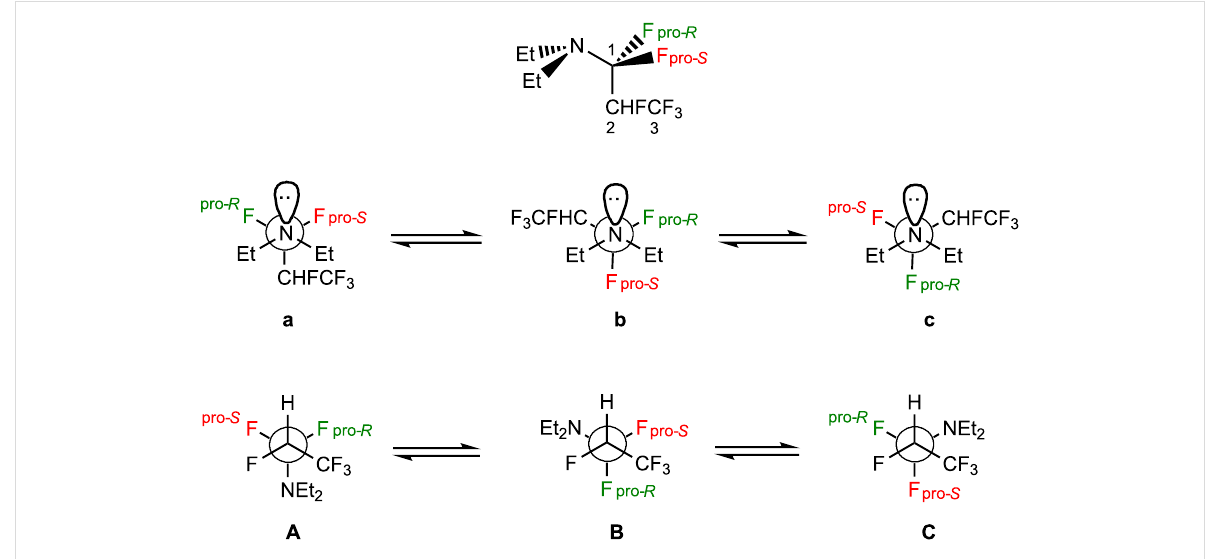
Figure 1: Structure of Ishikawa´s reagent ( 1 ) and the respective Newman projections indicating the two key rotatable bonds.